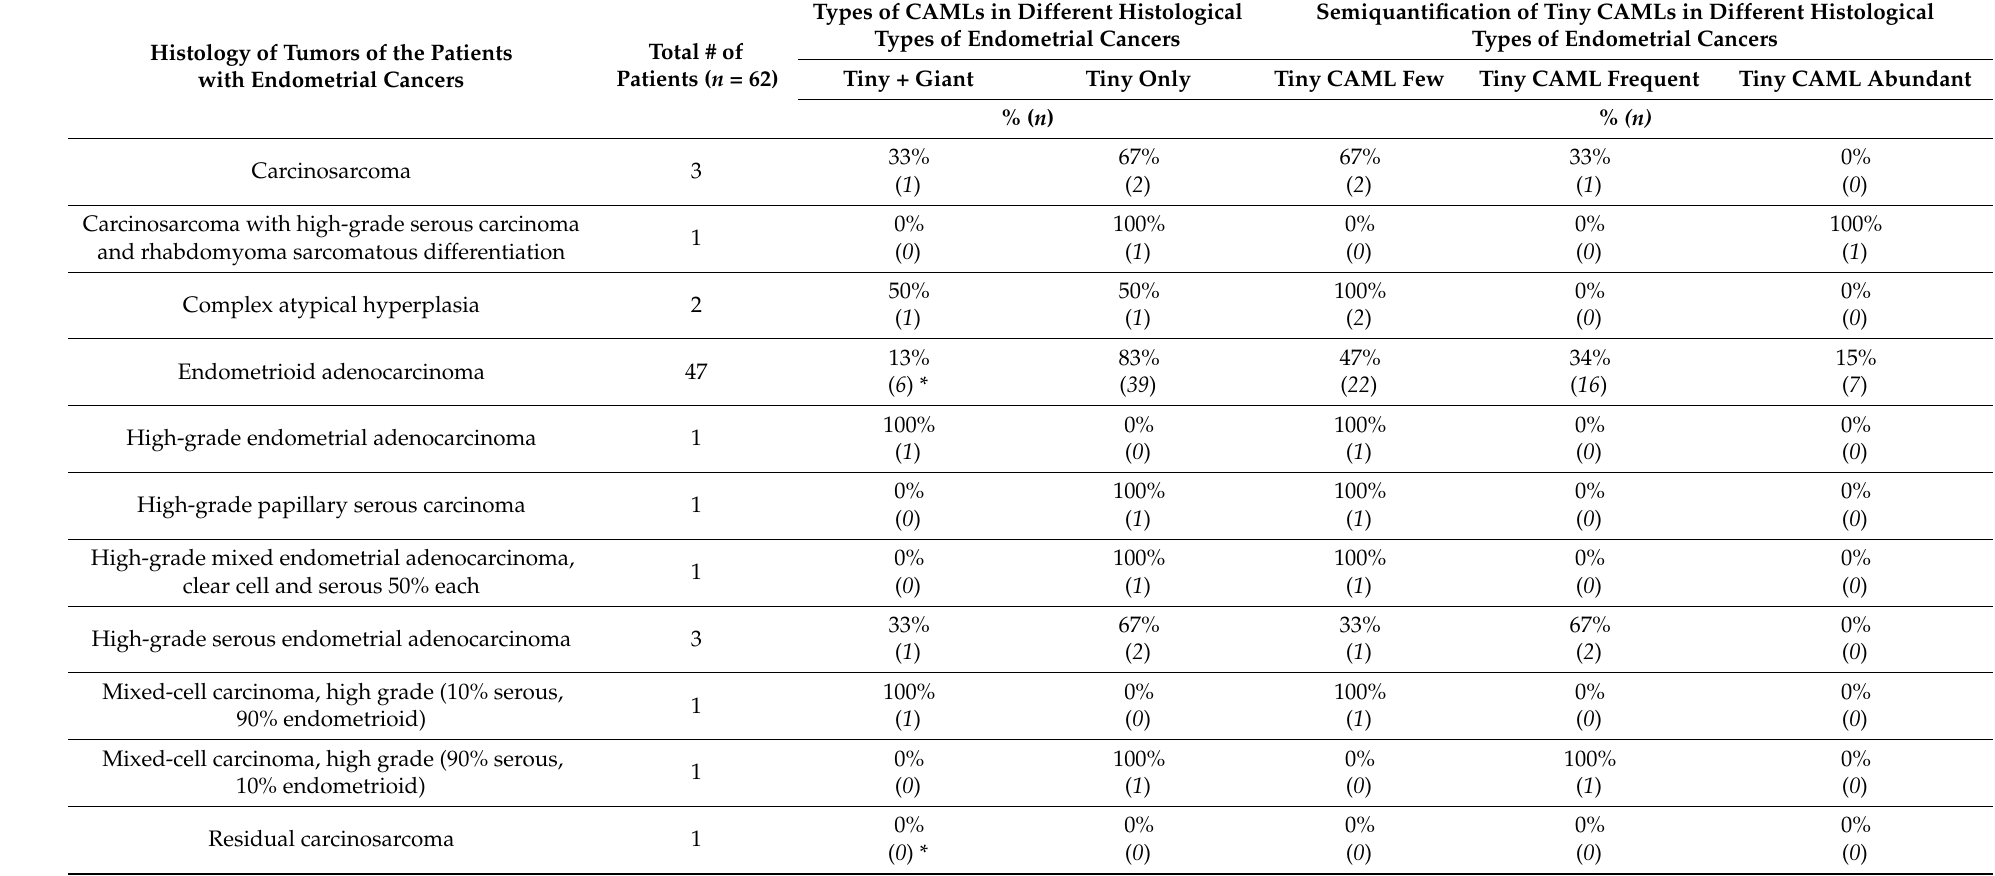
Table 5. Distribution of CAMLs in different histological types of endometrial cancers in our